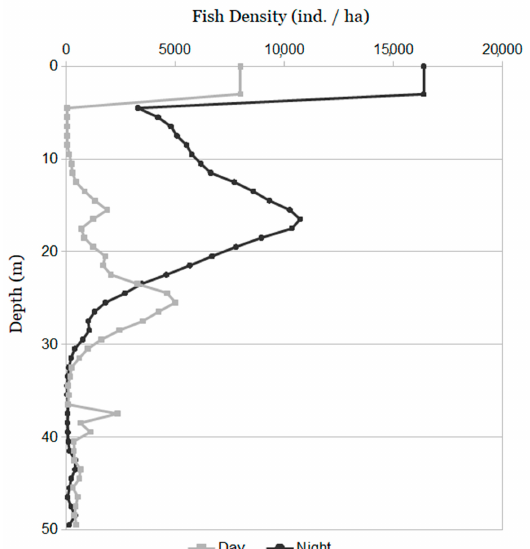
Figure 4. Vertical distribution of average density (inds. / ha) for each water column layer during day and night surveys.